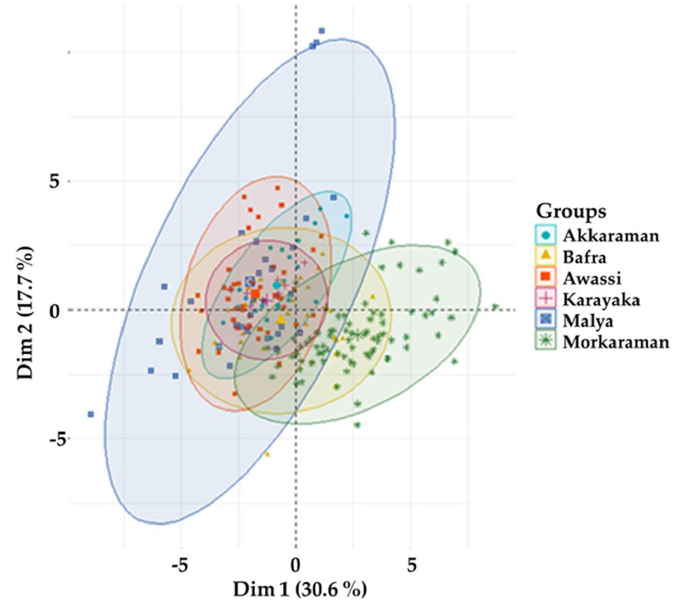
Figure 3. Variance of breeds for contributing on components 1 and 2. The dendrogram showing the clustering of the Akkaraman, Morkaraman, Karayaka, Awassi, Malya, and Bafra sheep breeds is given in Figure 4. Clustering results indicated that the six breeds were separated into three clusters. The first cluster consisted of the Bafra, Karayaka, and Awassi breeds, the second cluster consisted of the Akkaraman and Malya breeds, and the third cluster included only the Morkaraman breed. The nearest breeds were estimated as the Bafra and Karayaka with a similarity of 98.7%. Moreover, the similarity of the Bafra, Karayaka, and Awassi breeds was estimated as 96.8% due to the breeds included in the first cluster. The similarity rate of the Akkaraman, Karayaka, Awassi, Malya, and Bafra was estimated as 95.7%. The similarity rate of Akkaraman and Malya breeds was indicated as 97.5%. The overall similarity was found to be at the level of 93.2% among the sheep breeds.